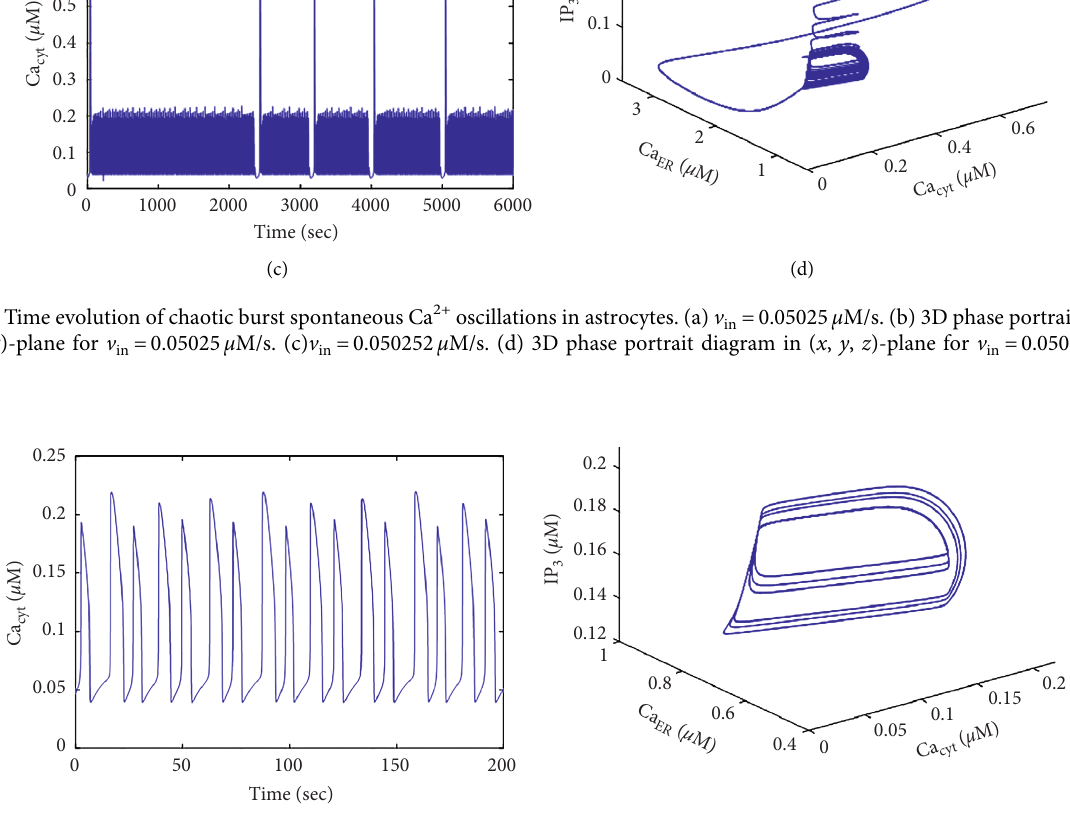
� 0.050254 μ M/s. (b) 3D phase portrait in